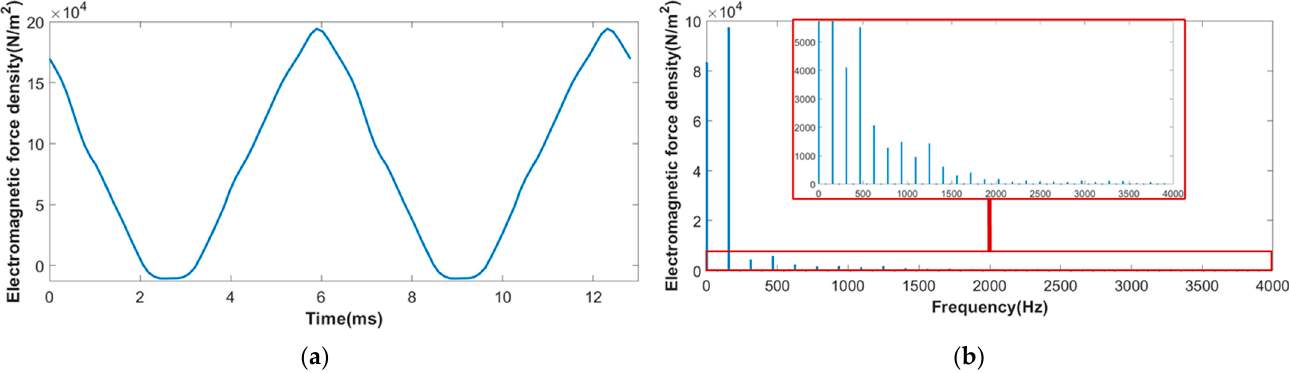
Figure 5. Electromagnetic force density under fundamental current power supply: ( a ) electromag- netic force density waveform and ( b ) spectrum diagram of electromagnetic force density.